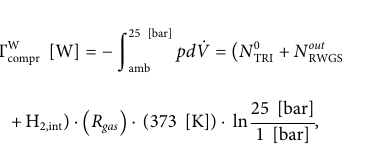
Frontiers in Energy Research |